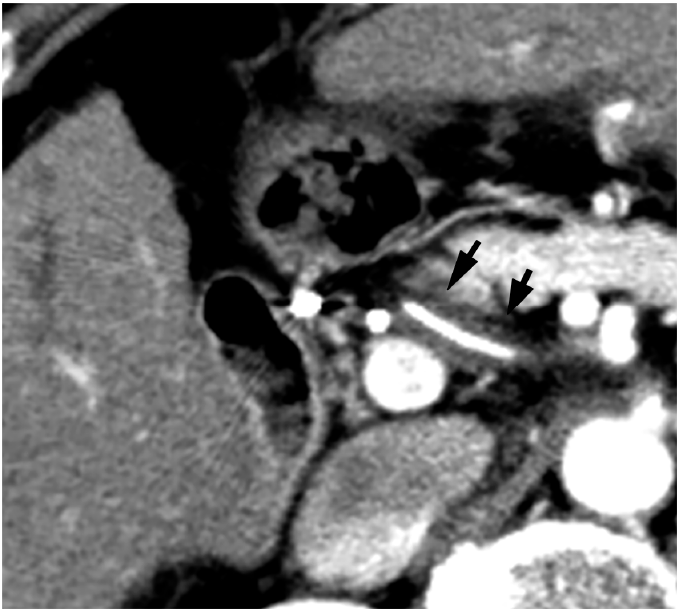
Figure 11. Arterial wall thickening (arrows) observed around the catheter which is inserted into the common hepatic artery for hepatic arterial infusion chemotherapy for the treatment of metastatic liver cancer.